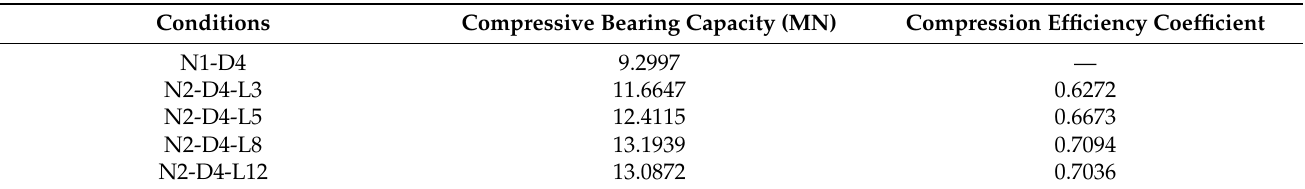
Figure 25. Compressive load-displacement curves with various blade spacing l/ D . ( a ) D / d = 1.5, n = 2; ( b ) D / d = 2.5, n = 2.